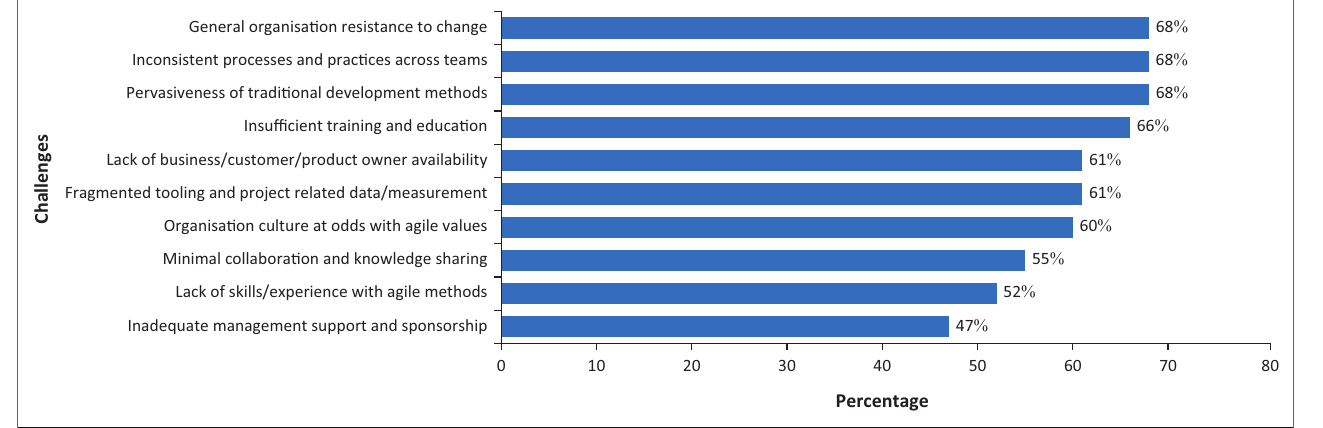
FIGURE 5: Challenges of adopting Agile